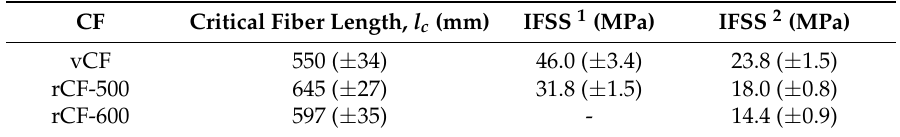
Figure 4. Weibull plots of tensile strengths of vCF (black), rCF-500 (red), and rCF-600 (blue). Table 2. Interfacial shear strength (IFSS) of the samples cured in a conventional